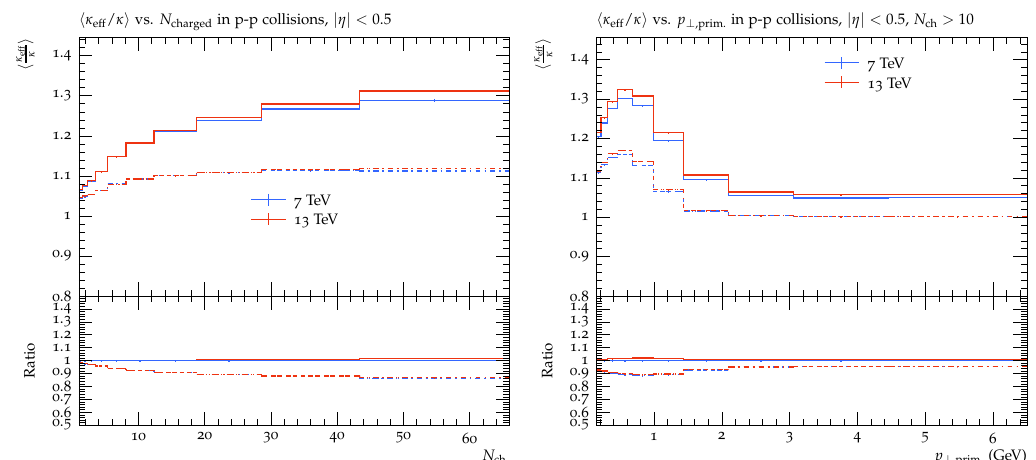
/κ 〉 vs. N > 10 (right). Solid lines have Figure 2: 〈 κ (left) and vs. p ⊥ for N eff ch. ,prim. ch. string radius R = 1 fm and dot-dashed lines have R = 0.5 fm. Blue and red lines are for minimum-bias event at 7 and 13 TeV